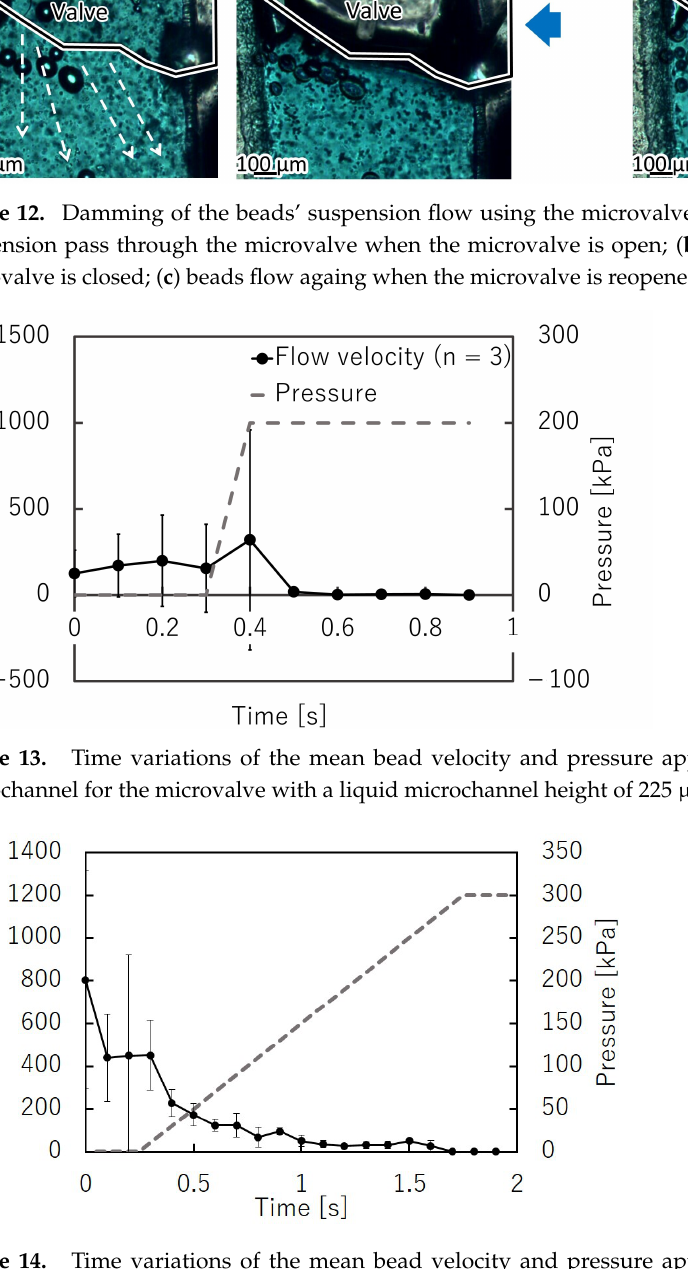
Figure 14. Time variations of the mean bead velocity and pressure applied to the pneumatic microchannel for the microvalve with a liquid microchannel height of 350 µ m ( n =